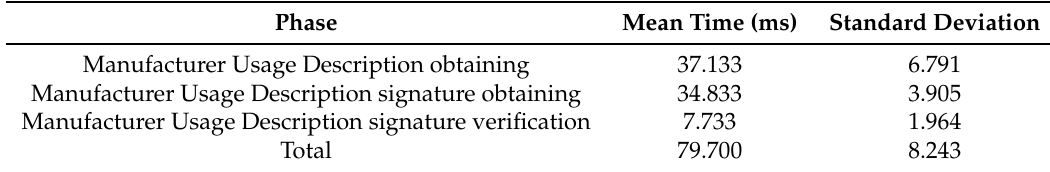
Table 4. Manufacturer Usage Description phases performance.